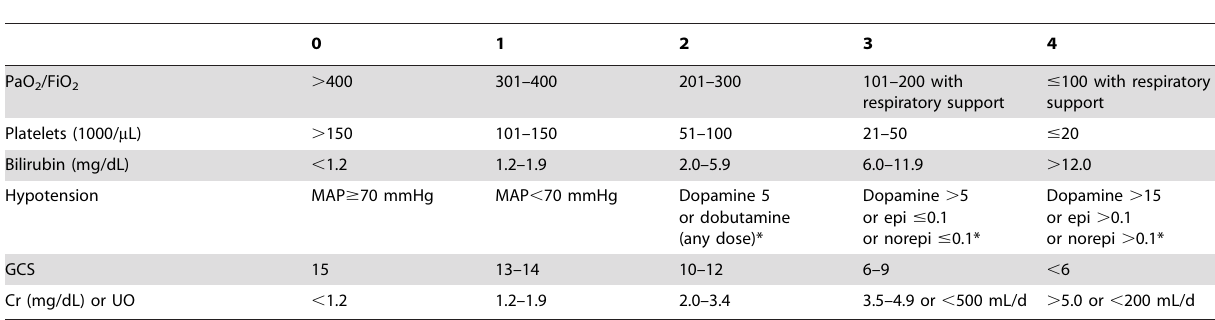
Table 1. SOFA scoring system.